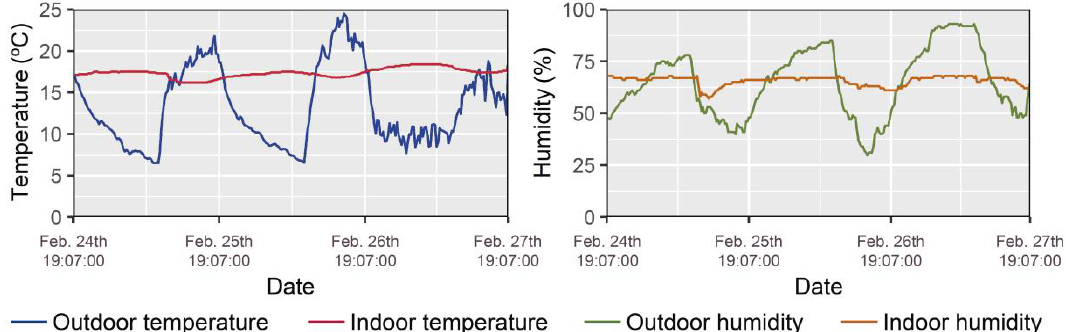
Figure 4. Part of the monitored time series of indoor and outdoor temperature and humidity of the building.